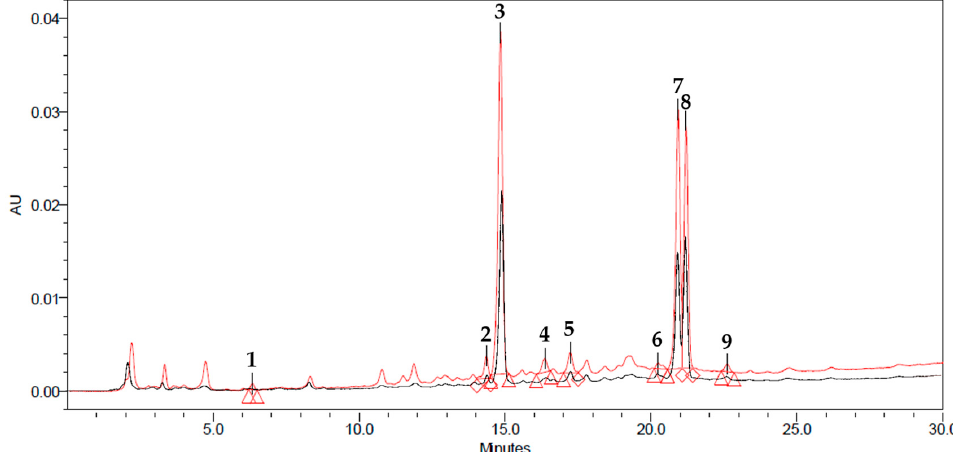
Figure 1. HPLC–PDA chromatograms of the extract from untreated artichoke stems (black line), and the extract from PEF-treated artichoke stems (red line). Peak identification: gallic acid ( 1 ), catechin ( 2 ), chlorogenic acid ( 3 ), epicatechin ( 4 ), cynarine ( 5 ), sinapic acid ( 6 ), naringin ( 7 ), rutin ( 8 ), phlorizin ( 9 ). Table 2. Concentrations (mg/gDW) of gallic acid, catechin, chlorogenic acid, epicatechin, cynarine, sinapic acid, naringin, rutin and phlorizin (HPLC/PDA analysis) in the extracts from untreated and PEF-treated artichoke stems.